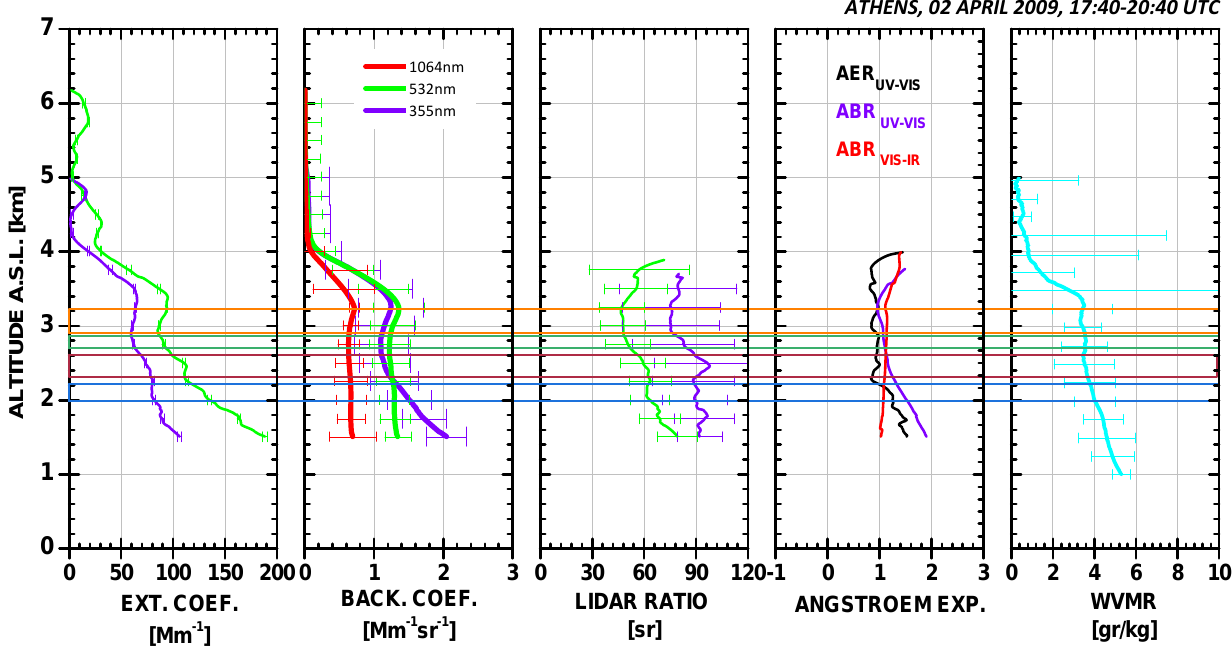
Fig. 5. Vertical profiles of the aerosol optical properties (extinction and backscatter coefficient, lidar ratio and ˚Angstr¨om backscatter- and extinction-related exponent), as well as of the water vapor to dry air mixing ratio (gkg − 1 ) (with error bars), as retrieved by the NTUA Raman lidar over Athens on 2 April 2009 (17:40–20:40UTC).